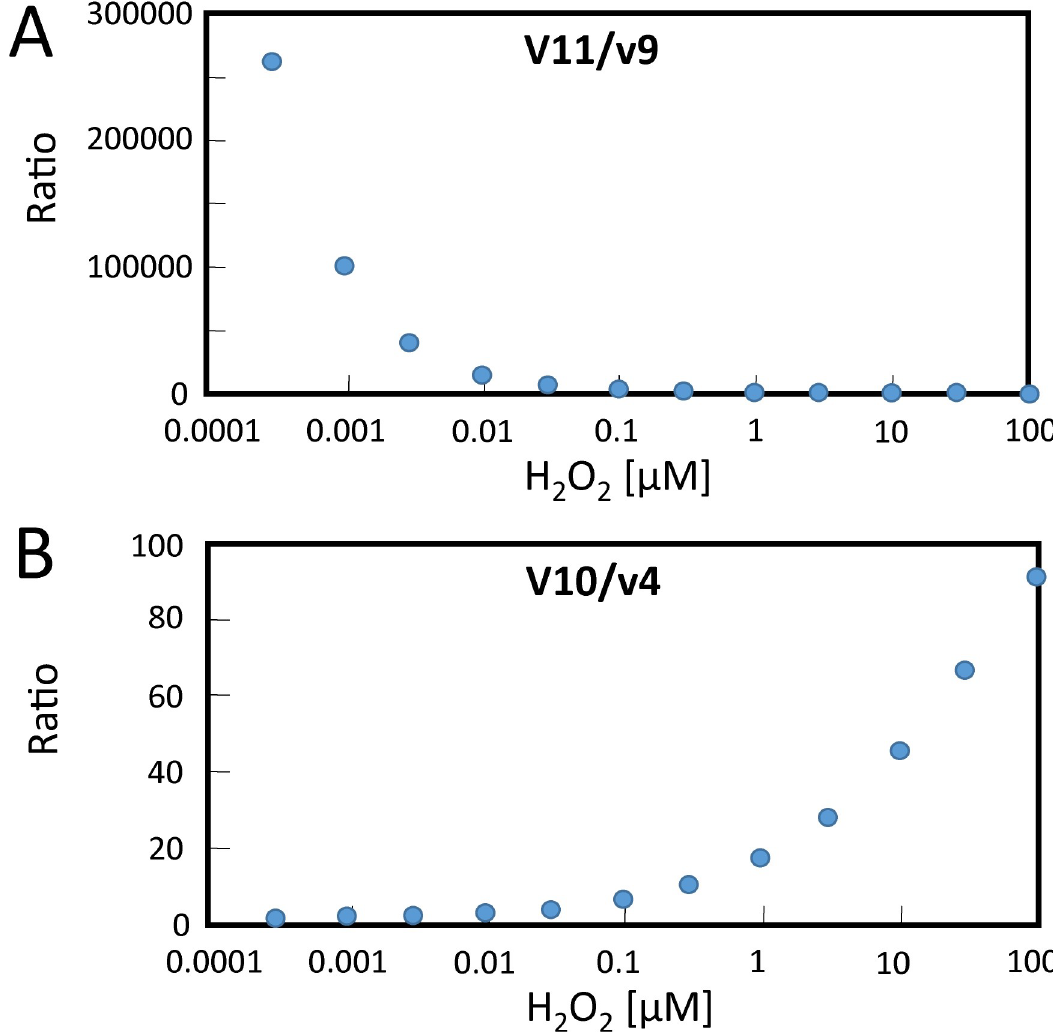
Fig 7. Steady state velocity ratios within the FTR/FNR network. Steady state velocities of the FTR/FNR-network (Fig 5A) were obtained after simulating the electron fluxes in the presence of various H 2 O 2 concentrations. The physiological concentrations of network components were calculated for 1 mg chlorophyll. The H 2 O 2 values were clamped in the simulation as given on the x-axis. (A) The ratio of the electron flux velocities from NADPH to metabolism (v11) relative to those from NADPH to thiol network (v9) were derived after 15 min. (B) Ratio of electron transfer rates from either TRX-f1 (v4) or NTRC (v10) to 2CysPRX as a function of clamped H 2 O 2